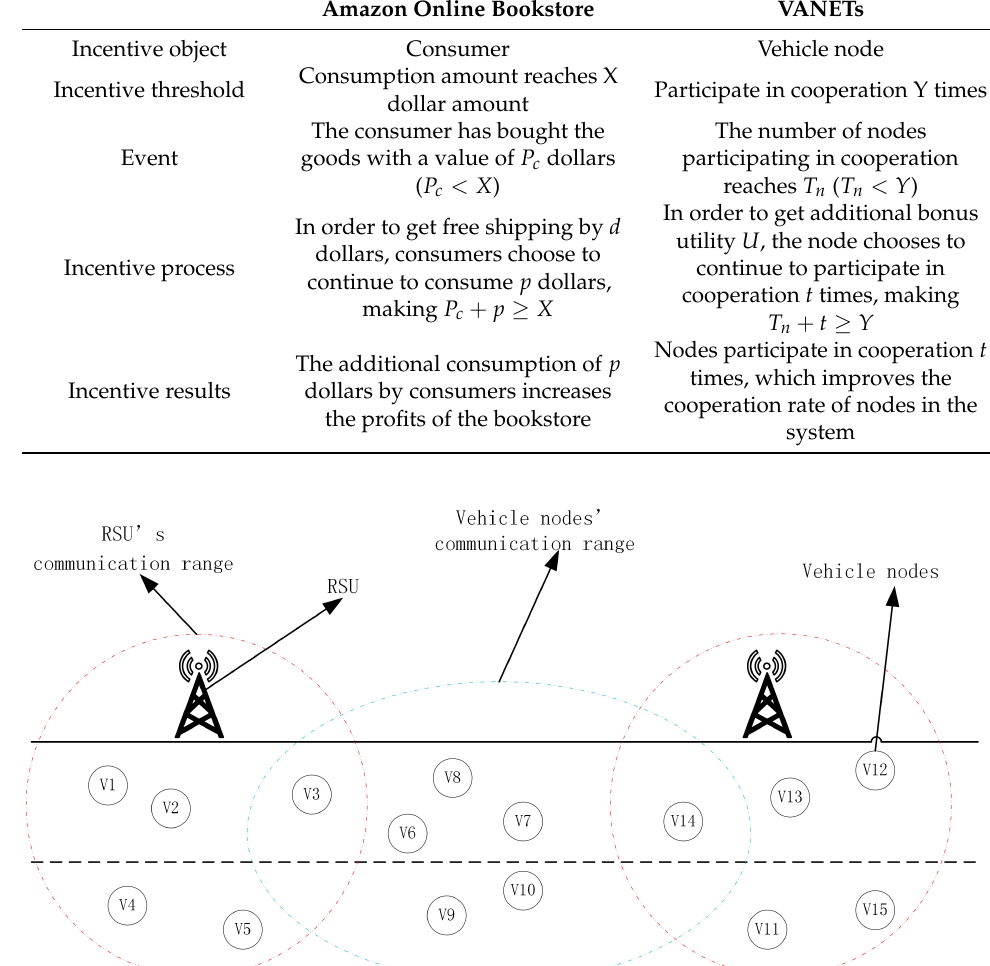
Figure 2. Physical model of